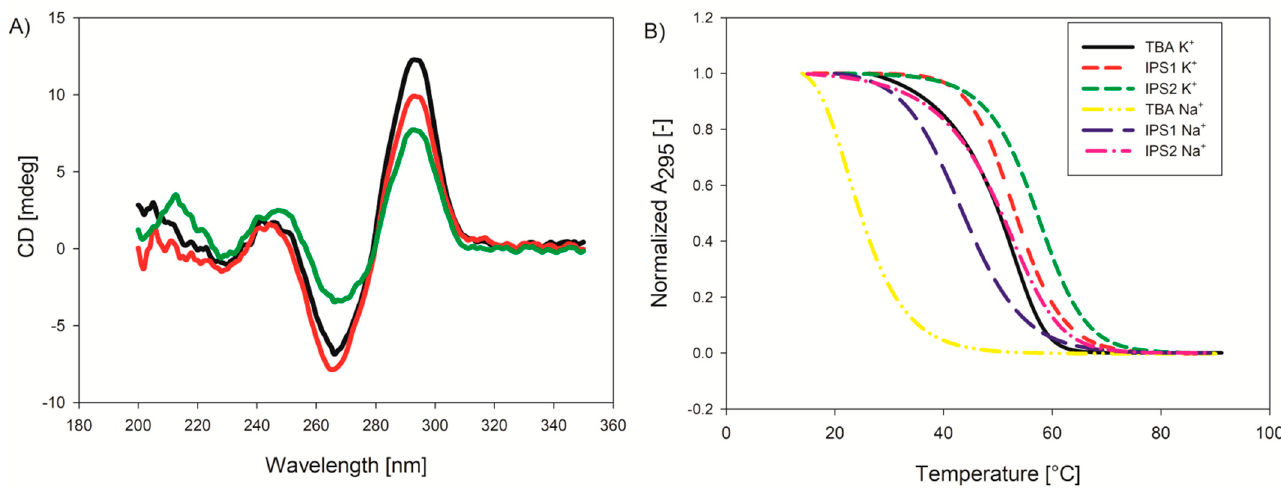
Figure 1. CD spectra and melting profiles of studied oligonucleotides. ( A ) CD spectra: black—TBA, red—IPS1, green—IPS2; ( B ) Melting profiles of studied oligonucleotides in the presence of potassium or sodium cations. Conditions: 10 mM Tris-HCl (pH = 8.0), 100 mM salt (NaCl or KCl), 2 µM DNA.